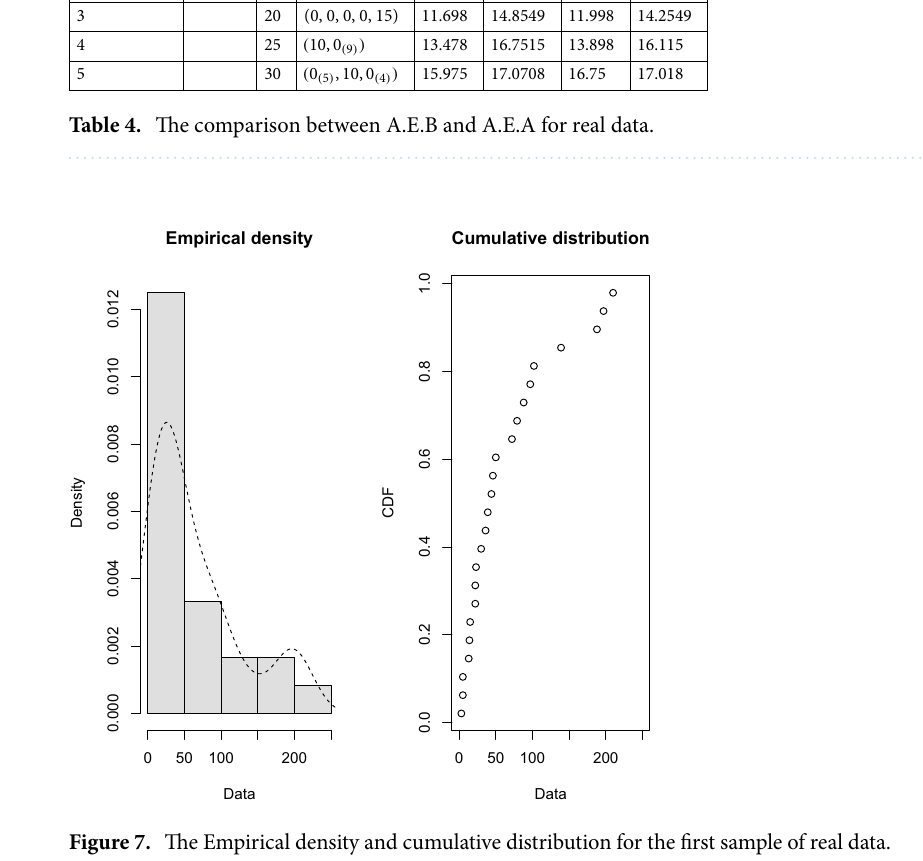
Figure 7. The Empirical density and cumulative distribution for the first sample of real data.